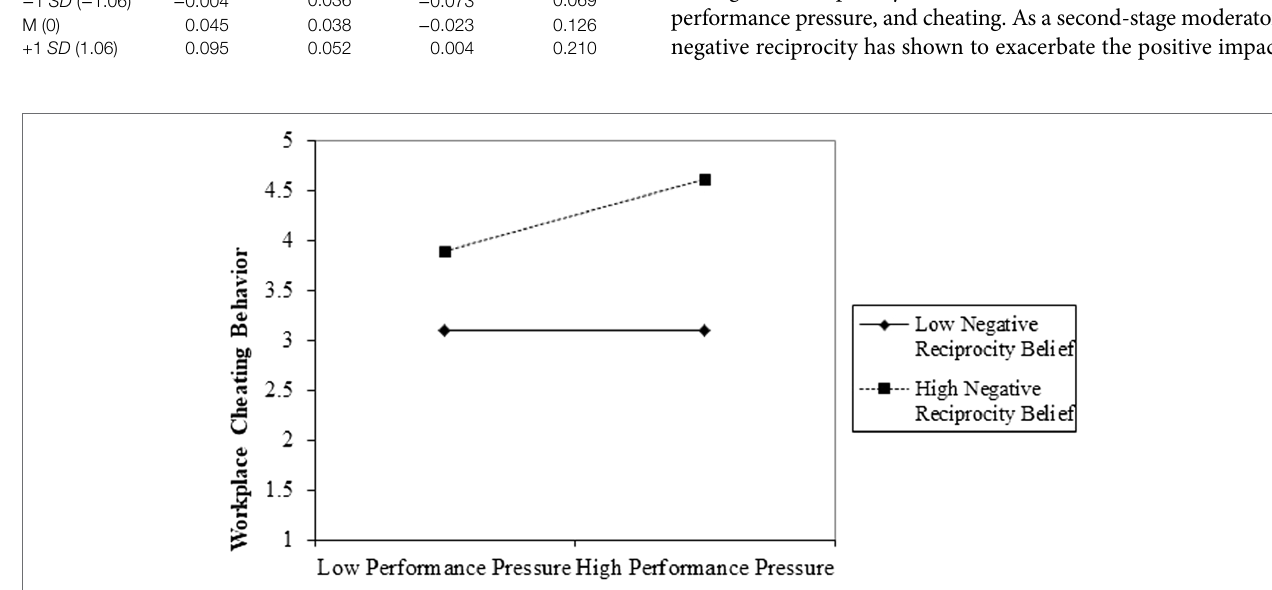
TABLE 8 | Conditional indirect effect of SBLM on cheating through performance pressure. Levels of negative